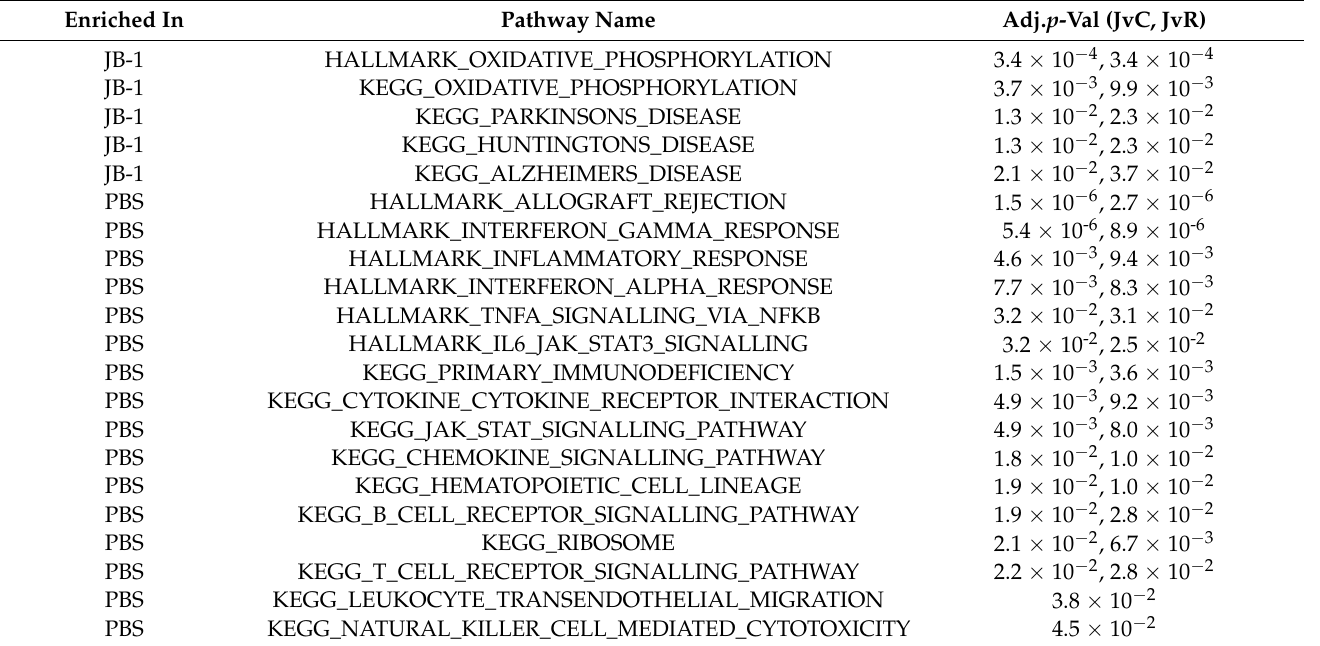
Table 1. Enriched pathways in JB-1 compared with PBS and compared with LR6475. The left column shows the relative direction of expression in JB-1 for each gene set and the right column shows the adjusted p -Value for each. Both JB-1 comparisons had nearly identical pathways and corresponding directions of expression, except for the last two entries on the table, which were significant only in the JB-1 vs. PBS